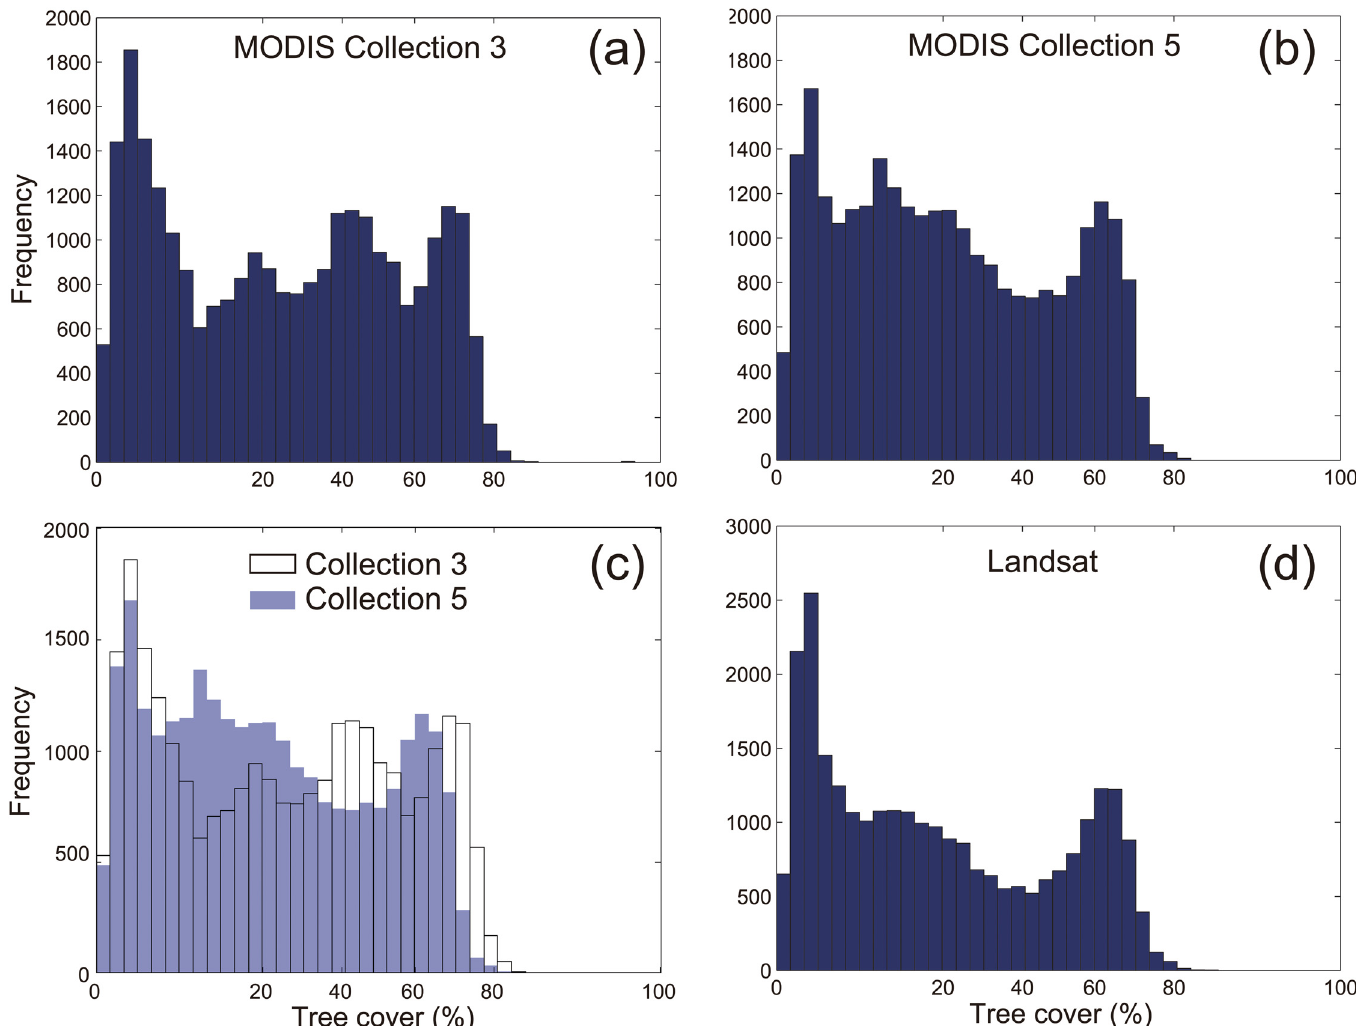
Fig 2. Comparison of tree-cover frequency distribution from different data sources. MODIS Collection 3 (a) and Collection 5 (b) in 2001, frequency difference between these two versions at each tree-cover bin (c) and Landsat VCF data (d) in 2000. Tree cover percentage values have been transformed through the arcsine-squared-root